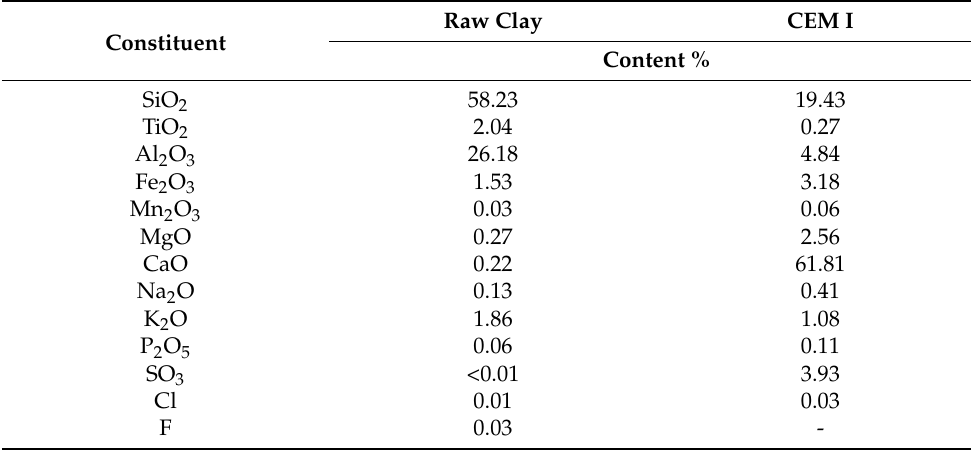
Table 1. Chemical composition of raw clay and Portland cement CEM I [15] by XRF